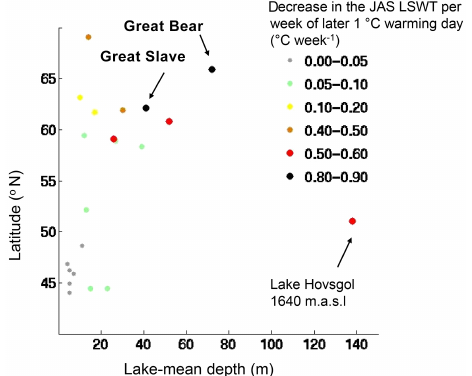
Figure 17. The relationship between latitude and lake-mean depth of the 21 trial seasonally ice-covered lakes and the decrease in the July–August–September (JAS) lake surface water temperature (LSWT) caused by the later 1 ◦ C warming day (as a result of using a high albedo, α 2: snow and white ice = 0.80 and melting snow and blue ice = 0.60 in place of the default albedo, α 1: snow and white ice = 0.60 and melting snow and blue ice = 0.10). The changes in the JAS LSWT, presented as the decrease in the JAS LSWT, per week of later 1 ◦ C warming day, ◦ Cweek − 1 , are categorised by coloured circles. This figure indicates that high latitude and deep lakes show a larger decrease in the JAS LSWT per week of later 1 ◦ C warming day, signifying that the LSWTs of these lakes are more responsive to changes in the 1 ◦ C warming day, than low lati- tude and shallow